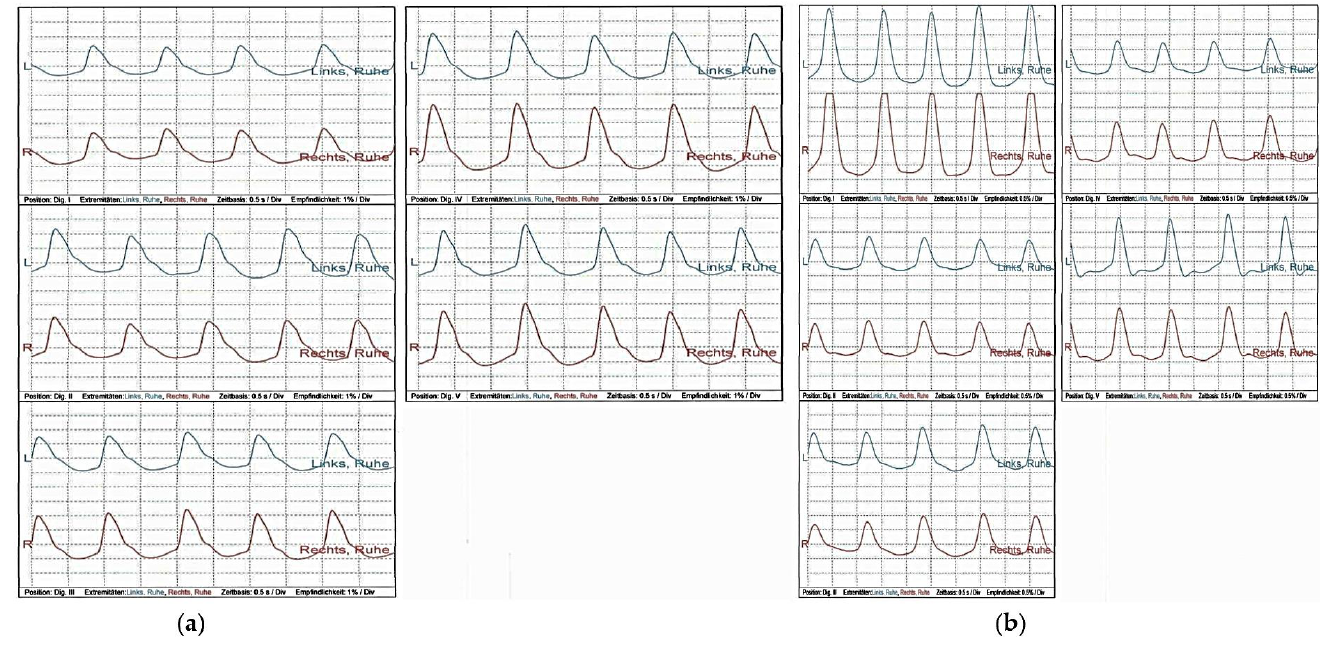
Figure 3. Optical pulse oscillography of all fingers ( a ) and toes ( b ) at rest. Optical pulse oscillography of all fingers and toes showed regular findings. Left ( a ): Fingers I – V, blue = left hand; red = right hand. Right ( b ): Toes I – V, blue = left foot; red = right foot.